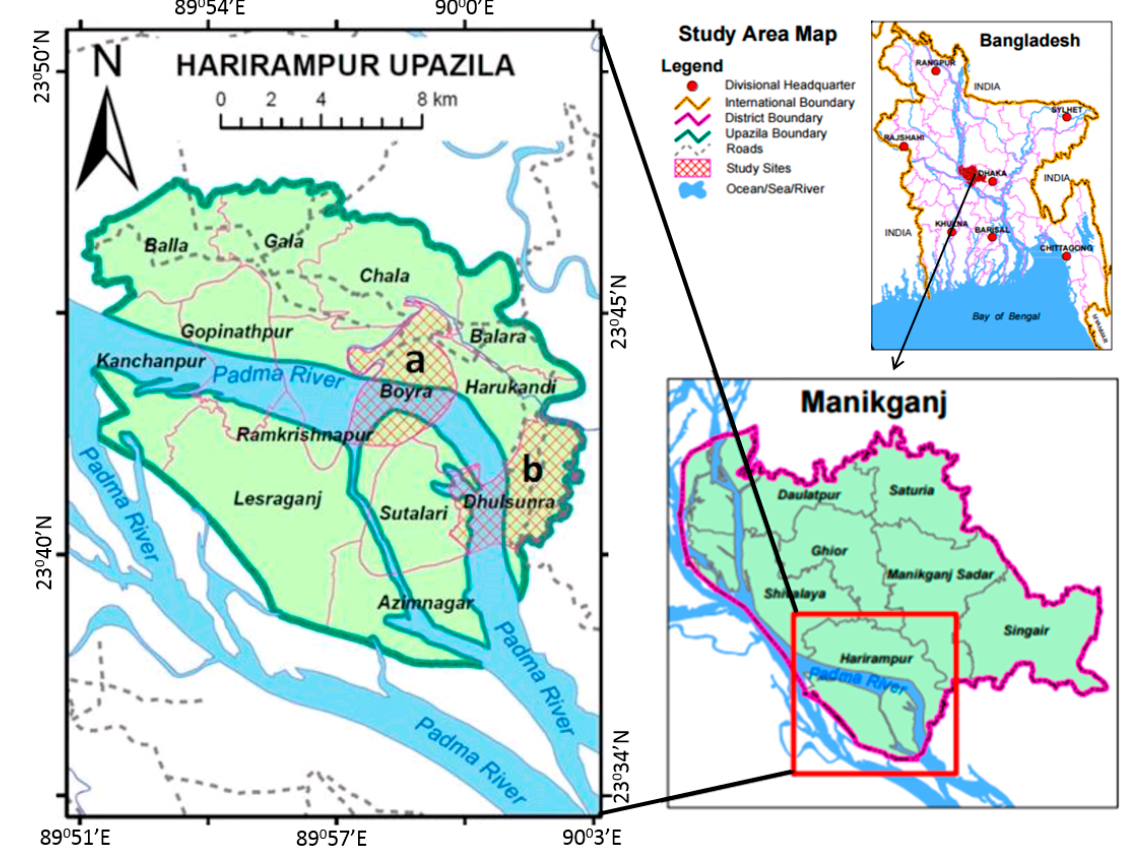
Figure 2. Map of the study sites under Harirampur upazila : ( a ) Andharmanik within Boyra union and ( b ) Dhulsura within Dhulsura union. Table 1. Profile of the study sites.